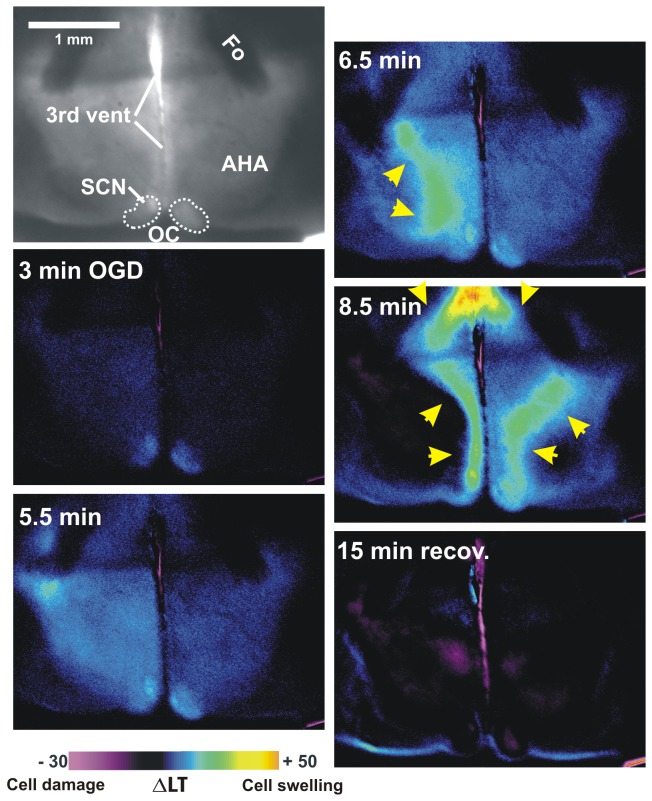
LT imaging of AD propagating through rostral hypothalamus.There is initial cell swelling particularly in SCN and then an AD wave front propagates latero-medially at 6.5 min of OGD (arrows). By 8.5 min, an AD front originating in thalamus invades dorsally (downward arrows). Following 15 min post-OGD, the hypothalamus shows little damage (purple) compared to the higher regions in Figures 3 and 4. AHA, anterior hypothalamic area.